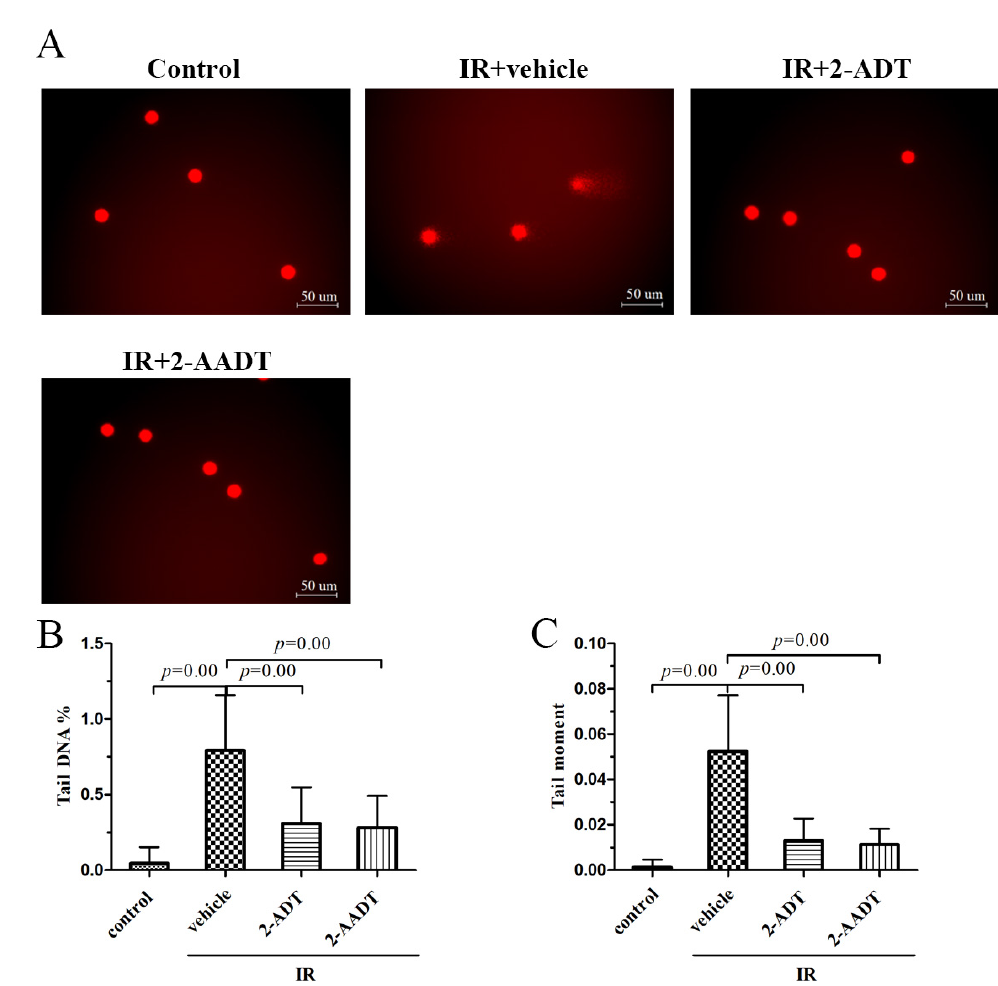
Figure 5. The effects of 2-ADT and 2-AADT on DNA damage in mice after 6.0 Gy radiation. 2-ADT and 2-AADT were administered i.p. 30 min before irradiation. ( A ) Representative images of lymphocytes from different groups. Scale bar, 50 µ m; ( B ) Tail DNA% and ( C ) Tail Moment (TM) reflecting DNA damage indirectly by the column graph. the data are presented as the mean ± SD. One-way ANOVA was used for statistical comparisons between groups. The p value shows the difference compared with the IR + vehicle